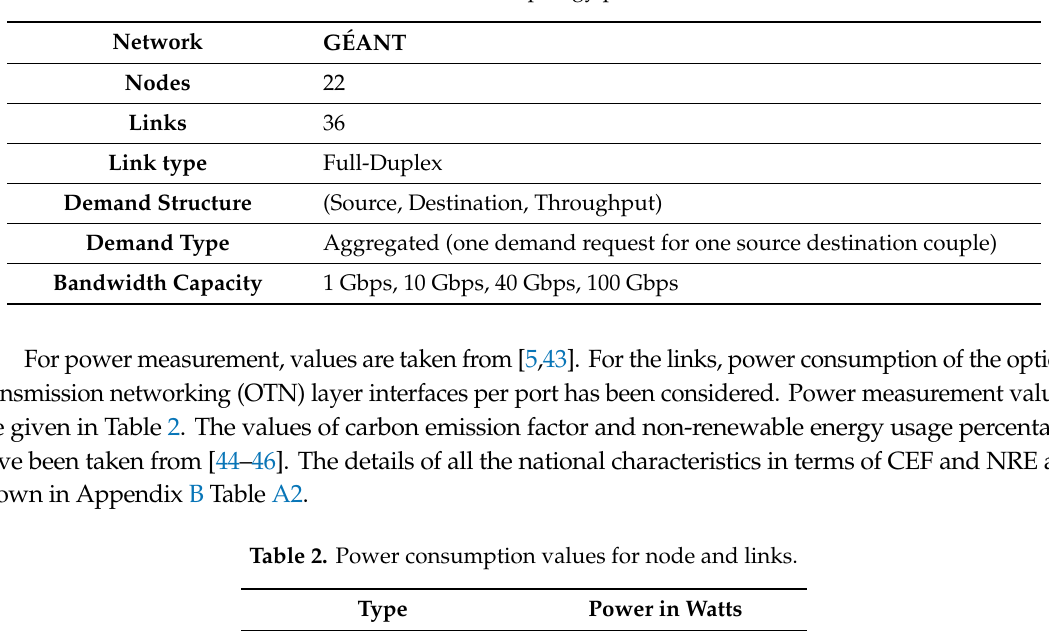
Table 1. Network topology parameters.